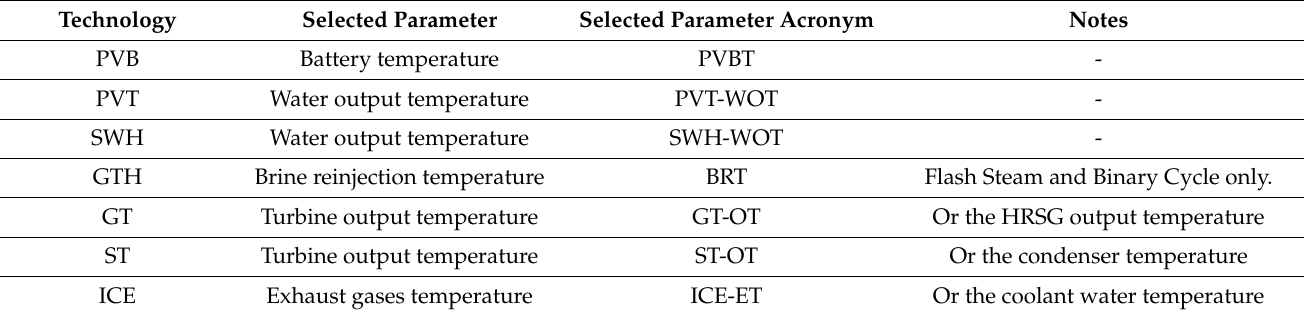
Table 5. Selected parameters to evaluate potential waste heat sources.